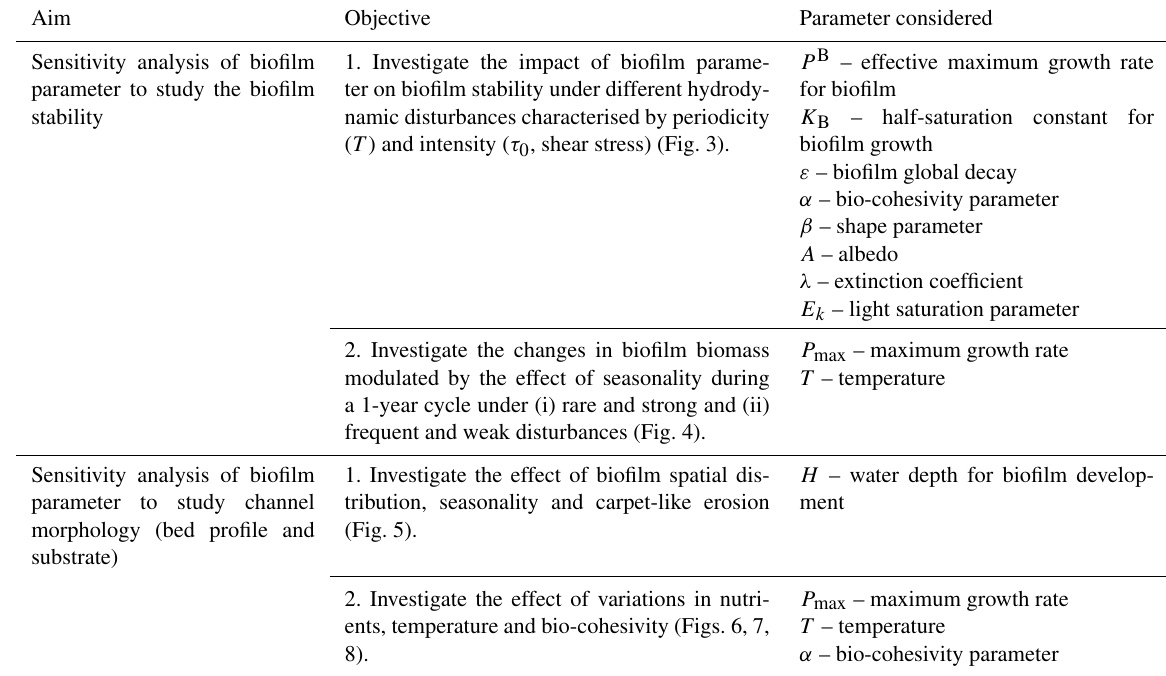
Table 3. Summary of the simulations performed in this